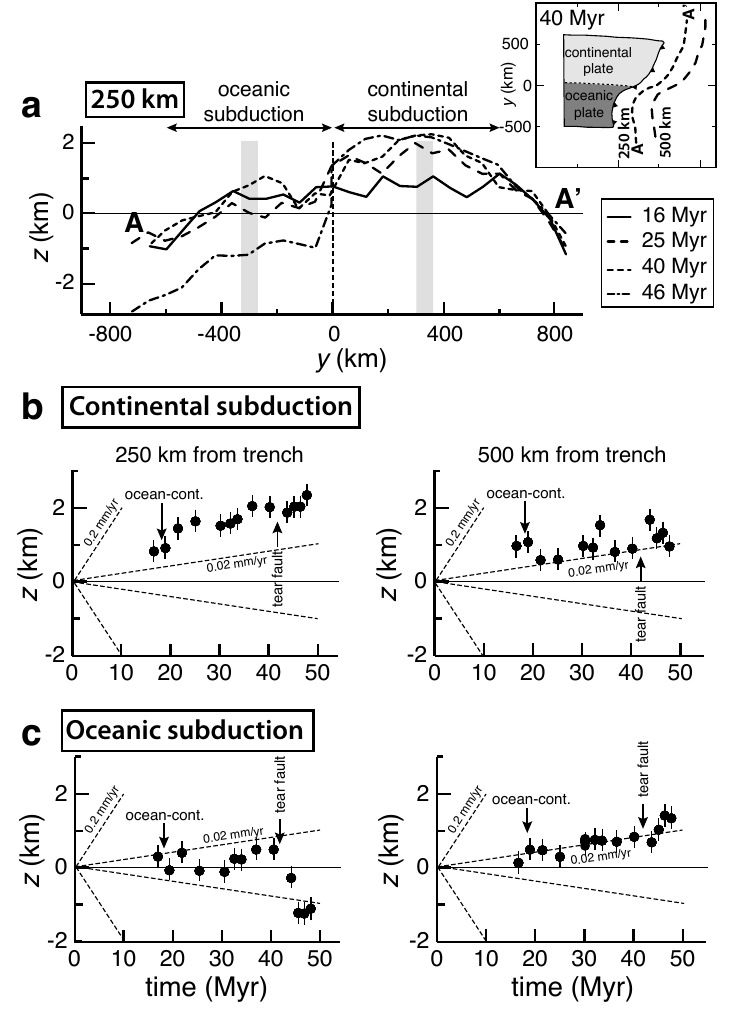
Fig. 8. (a) Dynamic topography measured at the surface of the asthenosphere for model 11 at a distance of 250km from the trench after 16, 25, 40 and 46Myr of subduction. Inset indicates the location of cross-sections at 250 and 500km from the trench after 40Myr of subduction. (b) Time-evolution of dynamic topography for the same model above the centre of the continental subduction zone at 250km from the trench (left panel) and 500km from the trench (right panel). Elevations are averaged on a 60km wide trench-perpendicular swath to remove any shorter wavelength perturbations (see position of swath on Fig. 8a). (c) Same as (b) for the oceanic subduction. Trends for uplift and downlift velocities of 0.02 and 0.2mmyr − 1 are indicated by dashed lines.